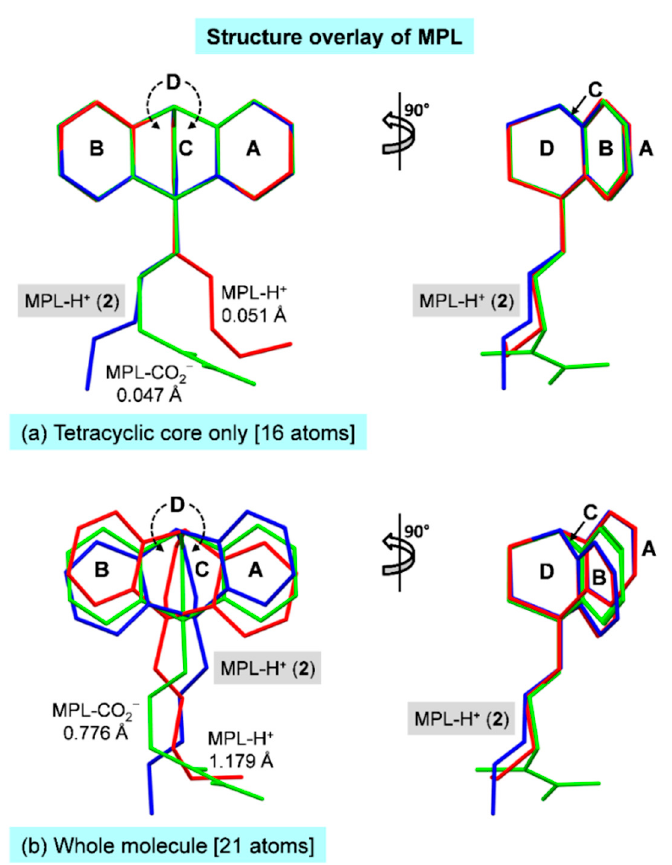
Figure 3. Rigid tricyclic core and flexible side-chain of TCAs are reflected by the structure overlays of protonated MPL in complex with β -CD ( 2 ) and maprotilinium carbamate hemihydrate (MPL-H + and MPL-CO 2 − ) [41], ( a ) the tetracyclic core and ( b ) whole molecule of MPL are included for the rms fit calculations.